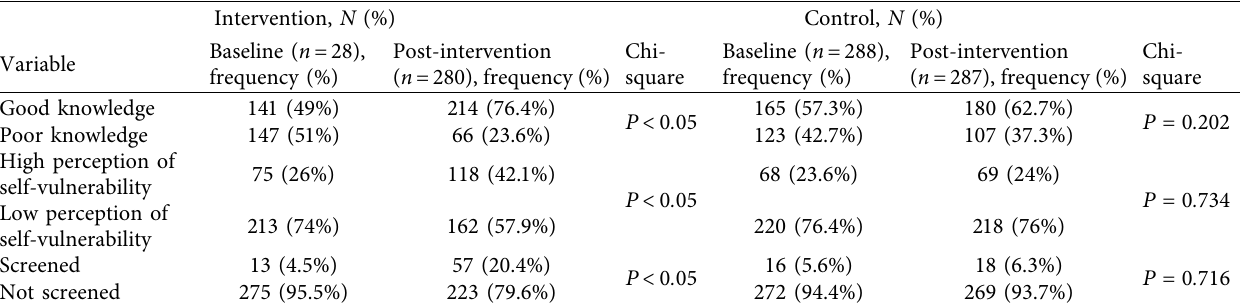
Table 4: Effectiveness of community-based health education on knowledge, perception of self-vulnerability, and uptake of